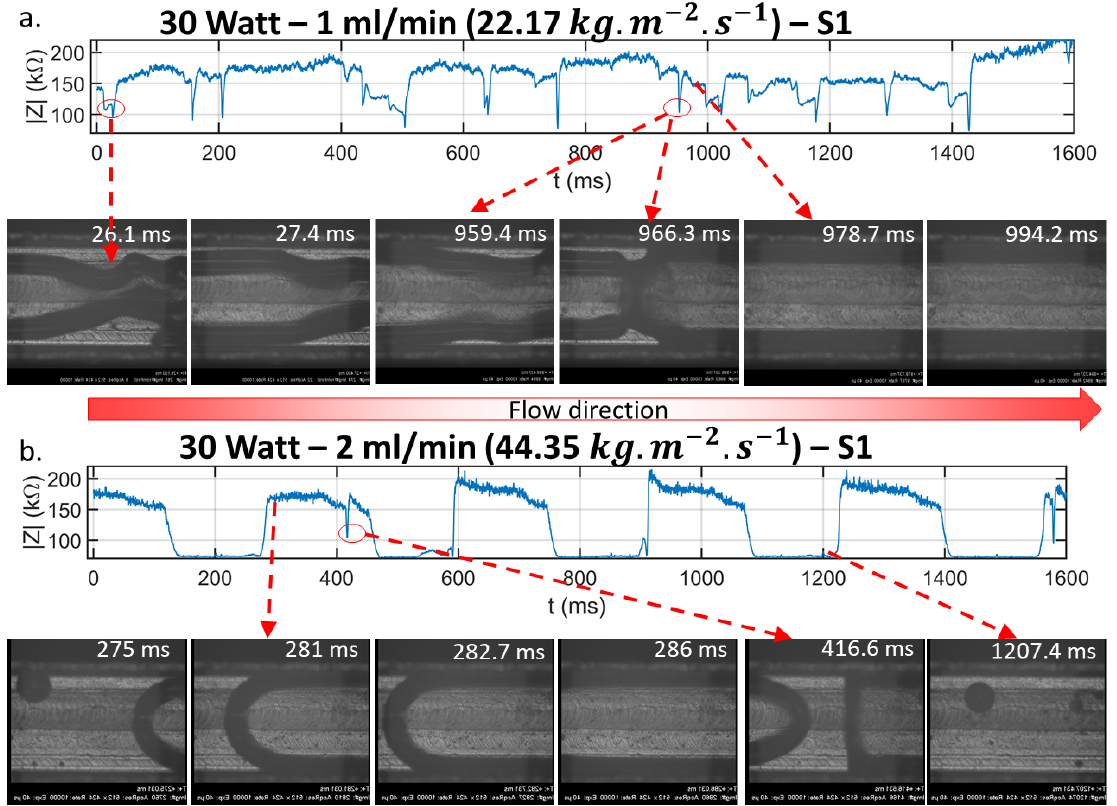
Figure 16. Example of impedance measurements and high speed videos. ( a ). An example of annular flow impedance measurement and high-speed pictures. ( b ). An example of slug flow with high speed